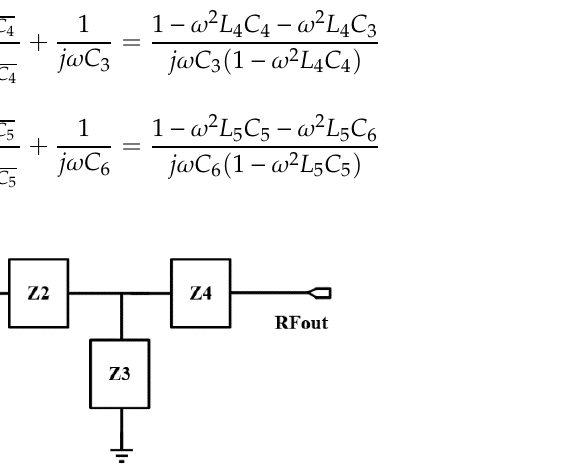
Figure 5. ( a ) 2D topology and ( b ) circuit model of the proposed filter.